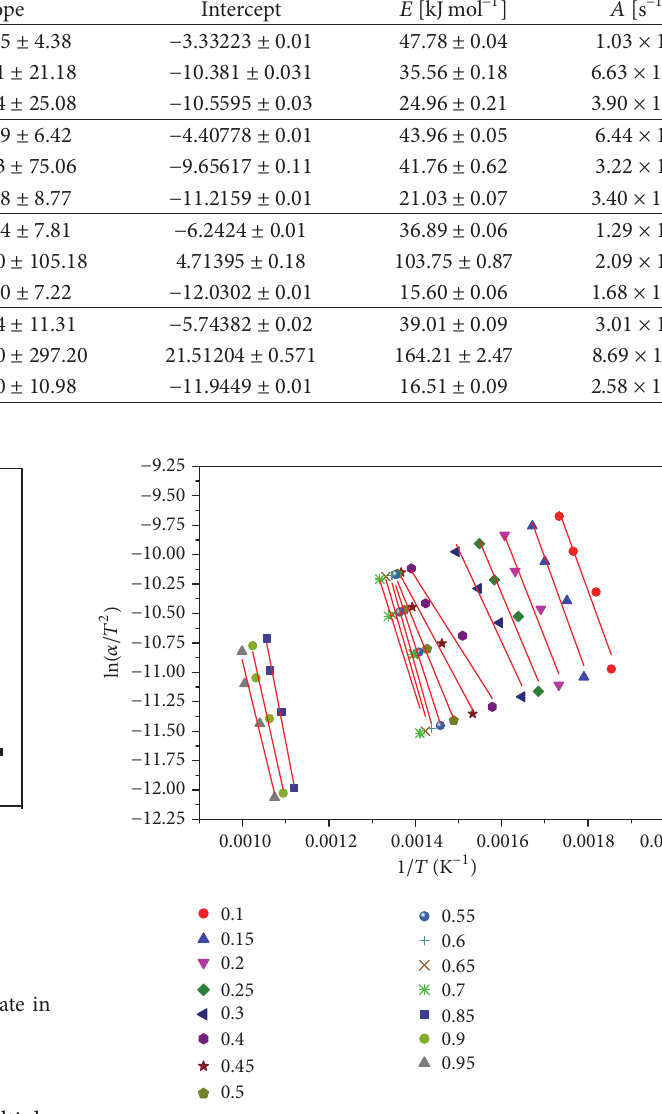
Figure 7: Arrhenius plot of ln (𝛼/𝑇 2 ) versus 𝑇 −1 at selected conver- sion